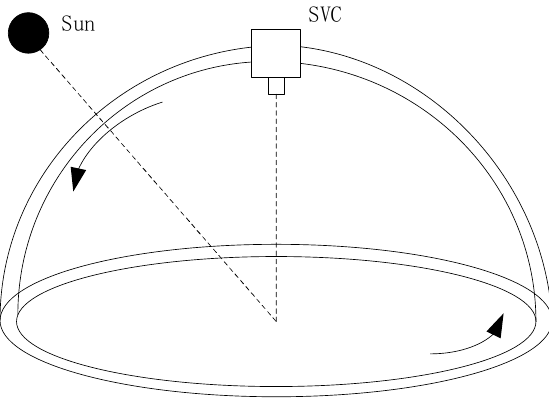
Figure 9. The BRDF measurement instrument. The anisotropy factor (ANIF) was used to interpret the BRDF effects of elevation and azimuth direction in this study [27,28]. BRDF ( θ i , ϕ i , θ v , ϕ v , λ ) ANIF ( θ i , ϕ i , θ v , ϕ v , λ ) = BRDF where BRDF ( θ i , ϕ i , θ v , ϕ v , λ ) is the BRDF for the reflected radiance in the azimuth ( ϕ v ) and zenith ( θ v ) directions at wavelength ( λ ), which comes from the incident radiance in the azimuth ( ϕ i ) and zenith ( θ i ) directions. BRDF N ( θ i , ϕ i , θ N , ϕ v , λ ) is measured in the ◦ nadir direction ( θ N = 0 ). Figure 10 shows the ANIF values of the gray target from the BRDF measurement.